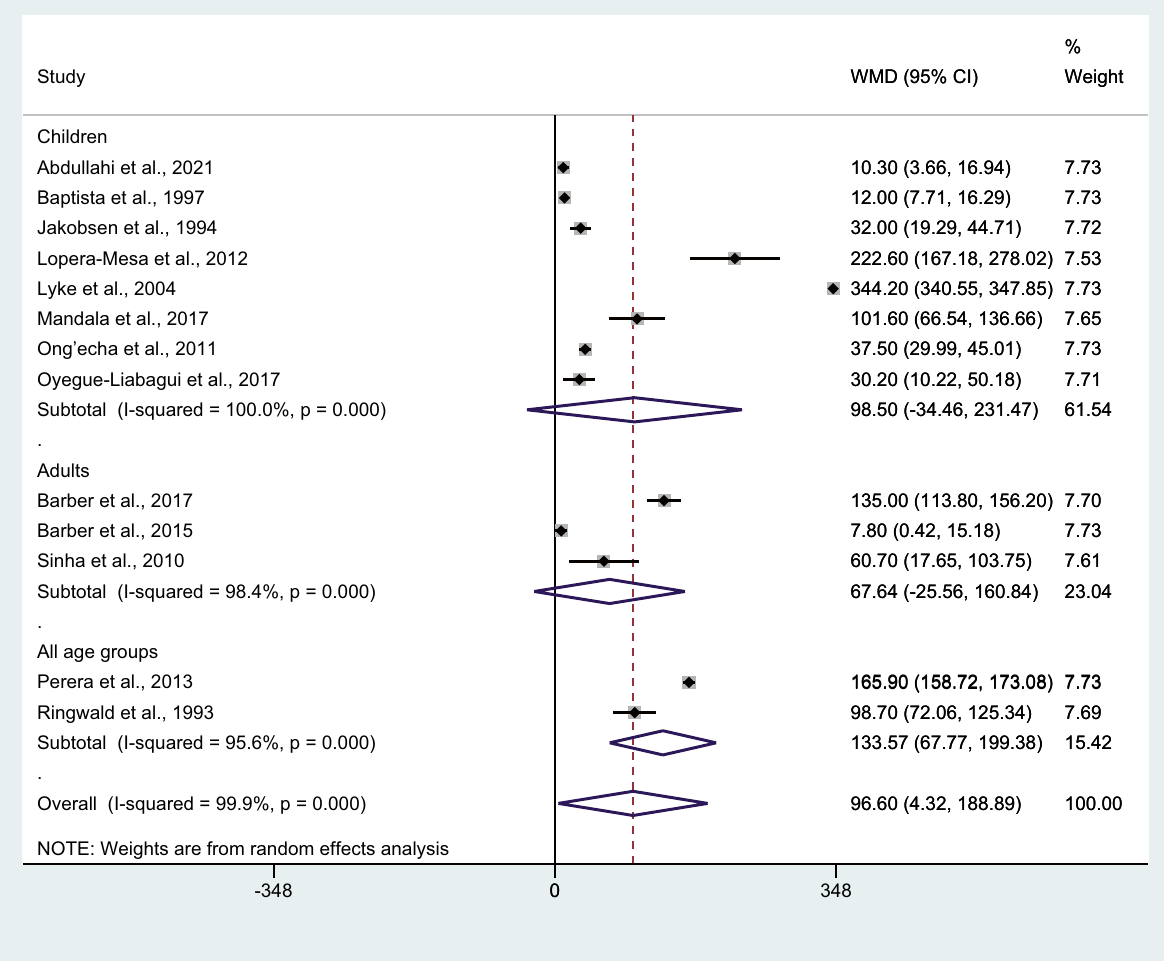
Figure 5. Differences in IL-6 levels between patients with severe malaria and non-severe malaria by age groups. Abbreviation: WMD, weighted mean difference; CI, confidence interval; black diamond symbol, point estimate; solid line in the middle of the graph at 0, zero effect size; Dashed red line: pooled WMD between the two groups; I 2 , level of heterogeneity; P = 0.00 or less than 0.05, significant